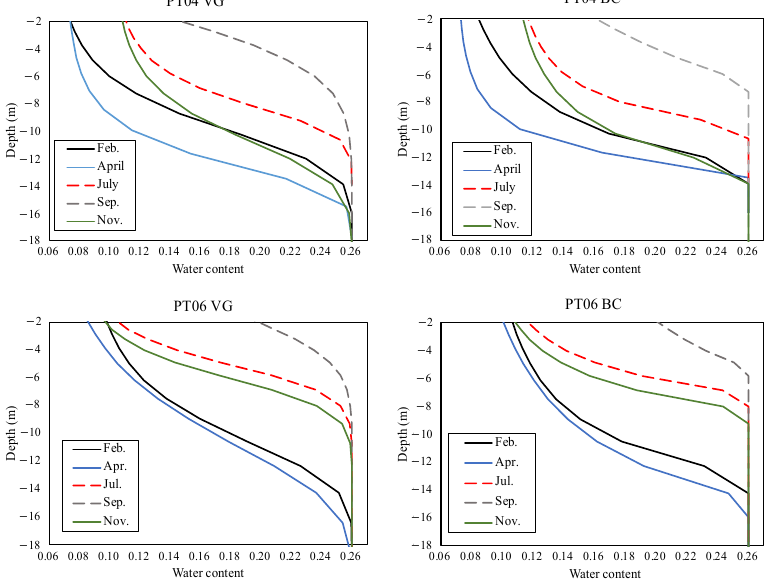
Figure 10. The Van Genuchten (VG) and Brooks–Corey (BC) for PT04 and PT06 sites for five different months. The dashed curve corresponds wet season while the solid curve represents the dry season.